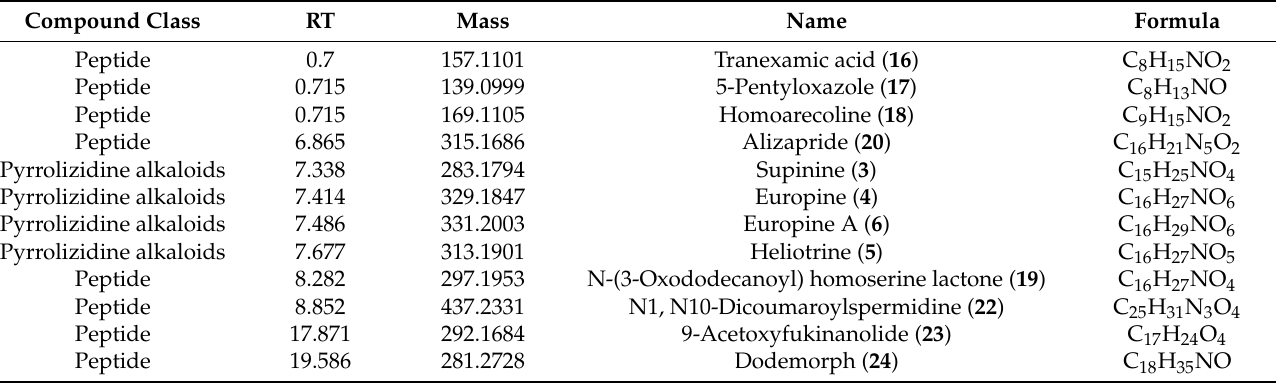
Table 3. Identification of secondary metabolites through UHPLC-Q-TOF-MS (Positive mode) from a methanolic extract of H. crispum